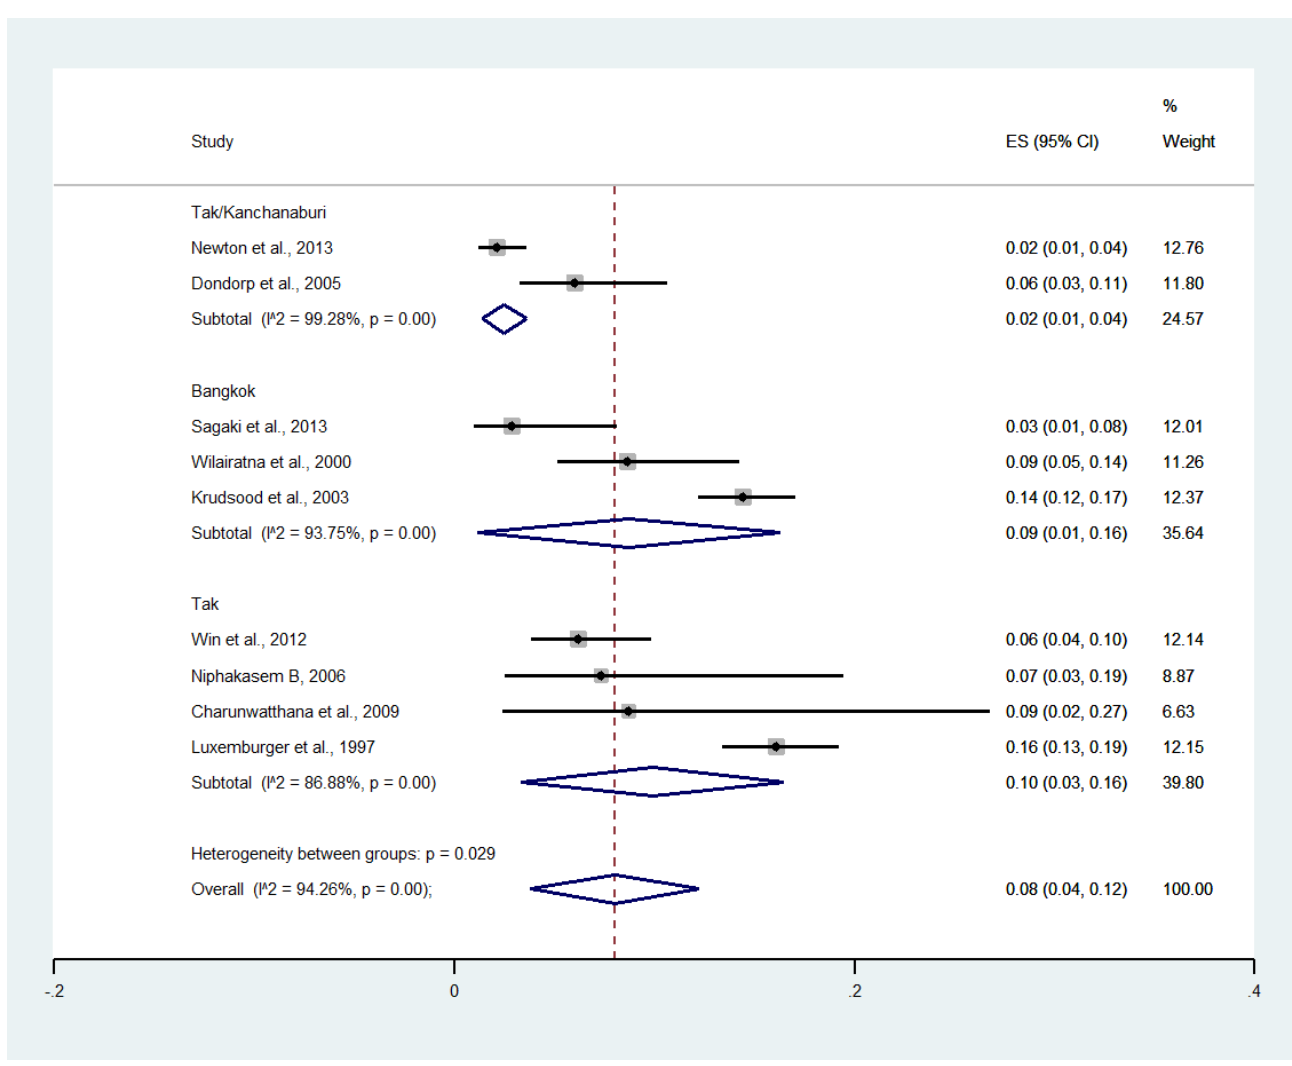
Figure 12. Subgroup analysis of the pooled prevalence of severe anemia among patients with severe malaria in Thailand . The label for the x - axis is the scale of estimated prevalence . Abbreviations; ES, estimated prevalence; CI, confidence interval .